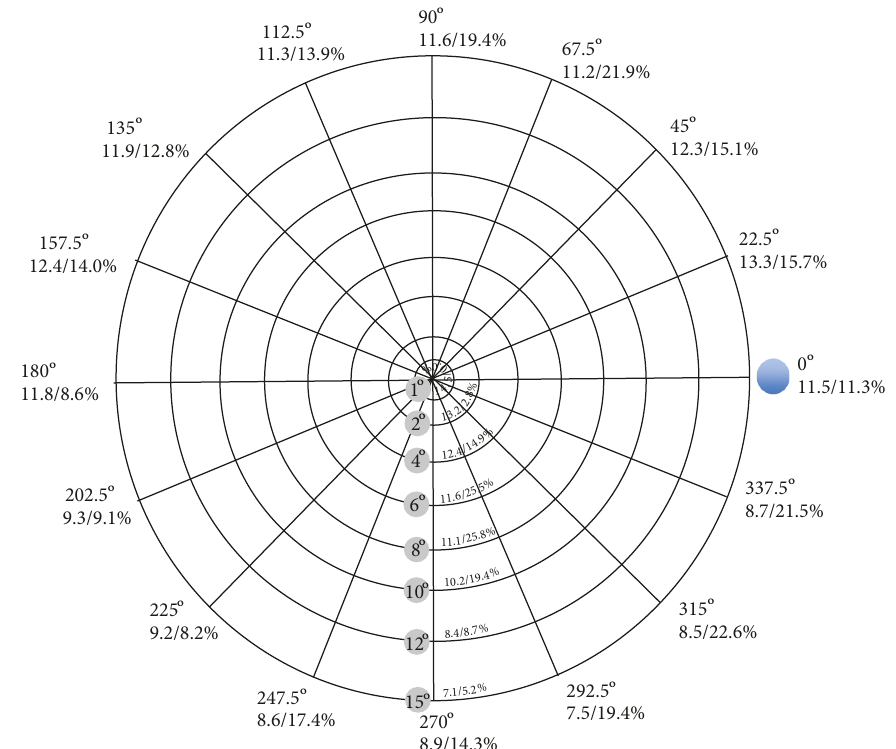
Figure 2: Visual fi eld (VF) pattern with 1 ° to 15 ° circle around the fovea and 16 lines spread out from the center of the fovea every 22.5 degrees with their mean values of microperimetry (dB) and ARAM+ (in percentage (%), based on ARAM+ and ARAM − ): microperimetry/ARAM+ in